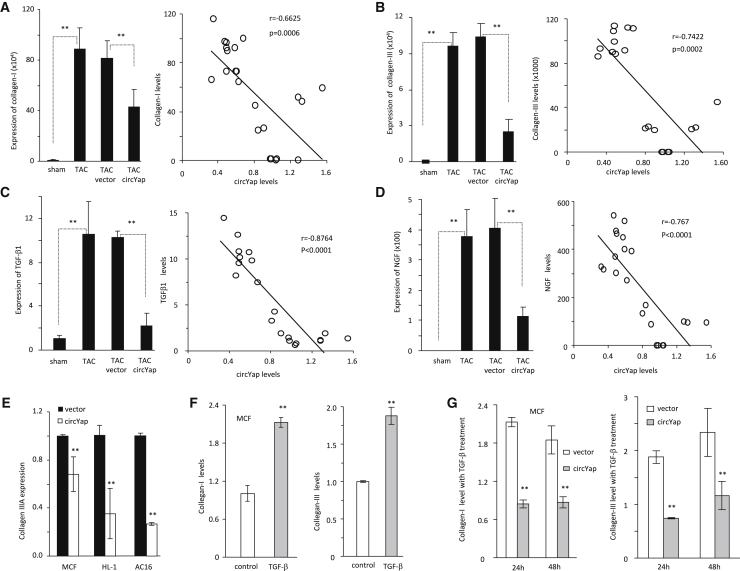
The Association of circYap with Fibrosis Markers(A) Left: expression of collagen-I in mice heart tissues of sham, TAC, TAC + vector, and TAC + circYap mice. n = 5. ∗∗p < 0.01. Right: correlation between collagen-I and circYap levels. n = 23. (B) Left: expression of collagen-III in mice heart tissues of sham, TAC, TAC + vector, and TAC + circYap mice. n = 5. ∗∗p < 0.01. Right: correlation between collagen-I and circYap levels. n = 20. (C) Left: expression of TGF-β1 in mouse heart tissues of sham, TAC, TAC + vector, and TAC + circYap mice. n = 5. ∗∗p < 0.01. Right: correlation between TGF-β1 and circYap levels n = 20. (D) Left: expression of NGF in mouse heart tissues of sham, TAC, TAC + vector, and TAC + circYap mice. n = 5. ∗∗p < 0.01. Right: correlation between NGF and circYap levels. n = 22. (E) Decreased expression of collagen-III in MCF, HL-1, and AC16 cells transfected with circYap. n = 4. ∗∗p < 0.01. (F) Expression of collagen-I (left) and collagen-III (right) in MCF cells treated with TGF-β1. Treatment with TGF-β1 significantly increased collagen expression. n = 3, ∗∗p < 0.01. (G) MCF cells transfected with vector or circYap plasmid were treated with 1 ng/ml TGF-β1 for 24 or 48 h. Transfection with circYap decreased collagen-I (left) and collagen-III (right) levels. n = 3. ∗∗p < 0.01.